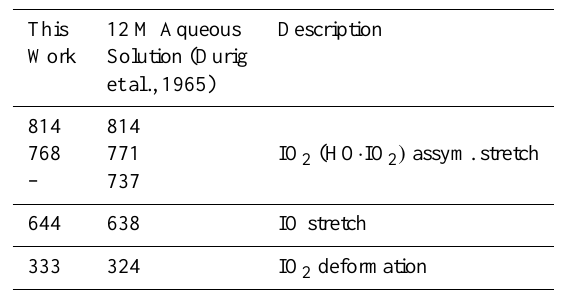
Table 1. Assignment of bands in Raman spectra of aqueous HIO 3 (cm − 1 ) .